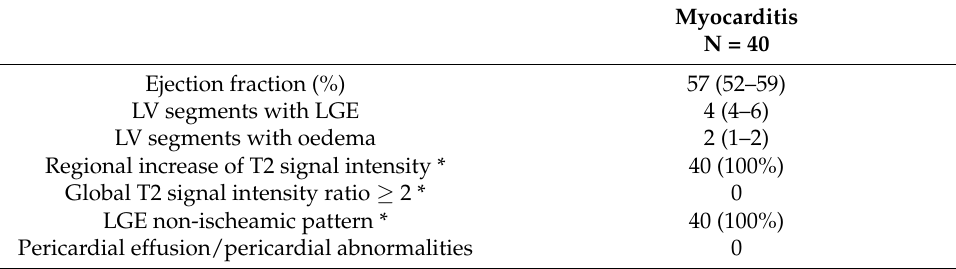
Table 1. Cardiac magnetic resonance findings.